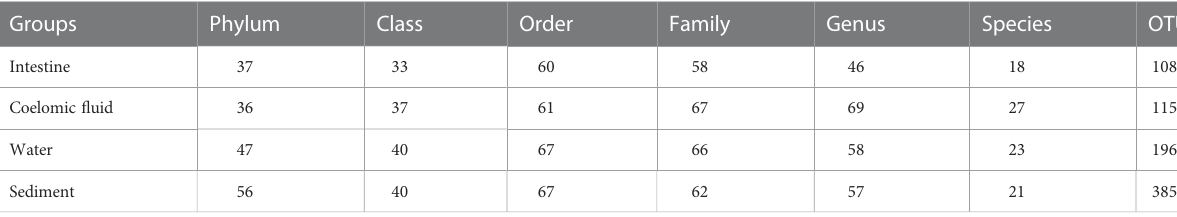
TABLE 1 Composition of bacterial communities in different samples.